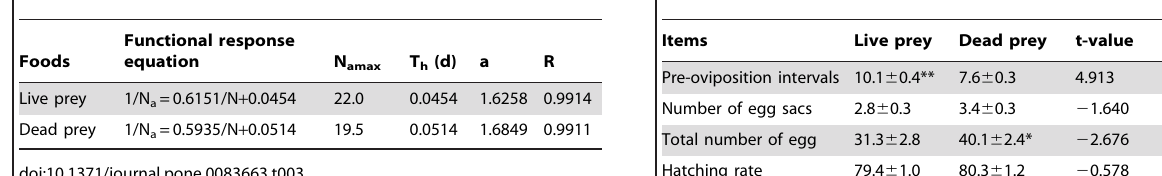
Functional response equation